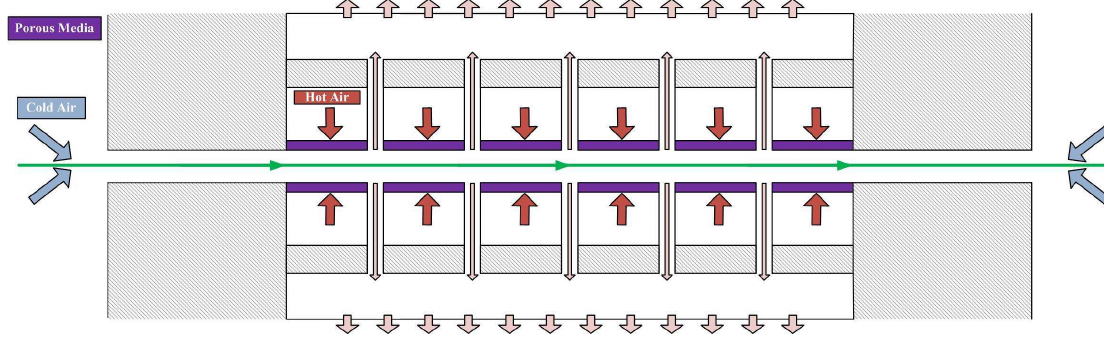
Figure 2. Model scheme without air curtains.